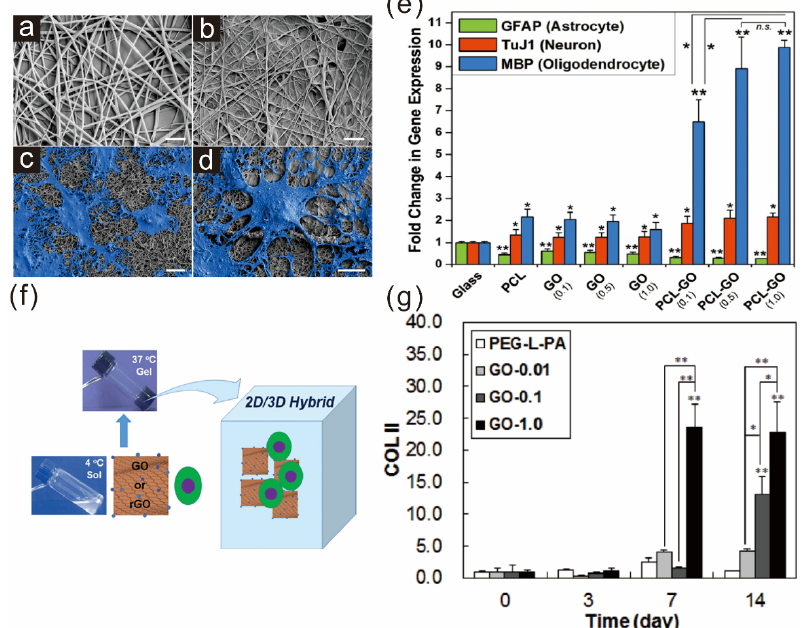
Figure 3. Graphene hybrid scaffolds enhancing stem cell differentiation into specific lineages: ( a ) nanofiber scaffold, ( b ) graphene ‐ nanofiber hybrid scaffold, and ( c – d ) differentiated neural stem